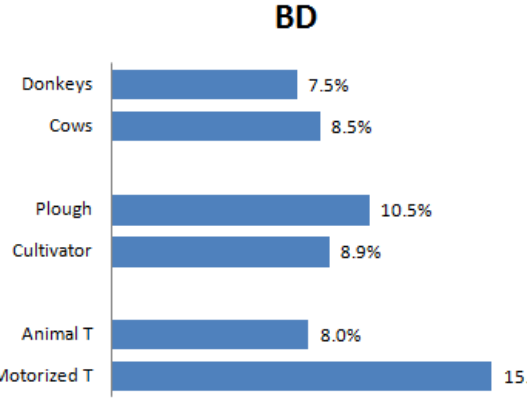
Figure 5: Relative changes in Bulk Density at 0-0.05 m depth after tillage operations: Traction, Implement and Animal